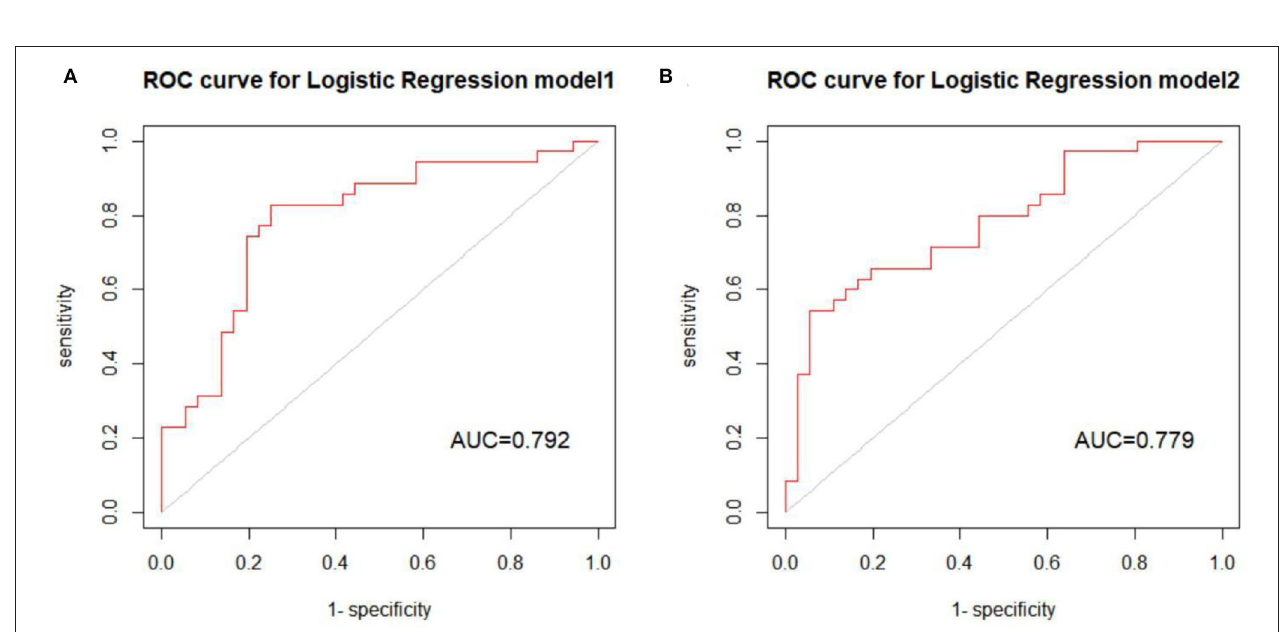
FIGURE 2 | (A) The ROC curve and AUC value of model1. (B) The ROC curve and AUC value of model2.